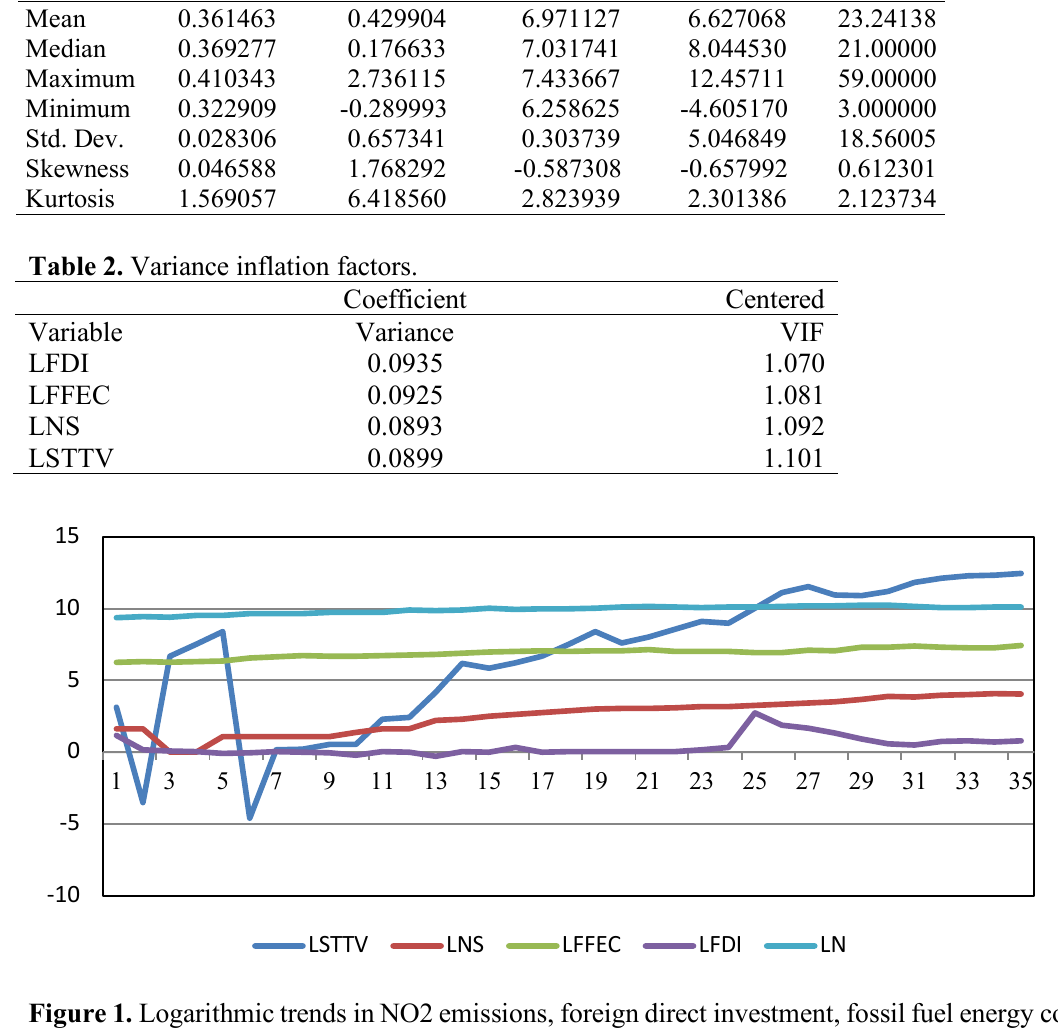
Figure 1. Logarithmic trends in NO2 emissions, foreign direct investment, fossil fuel energy consumption, stocks traded-total value, and number of students in Iran for the period